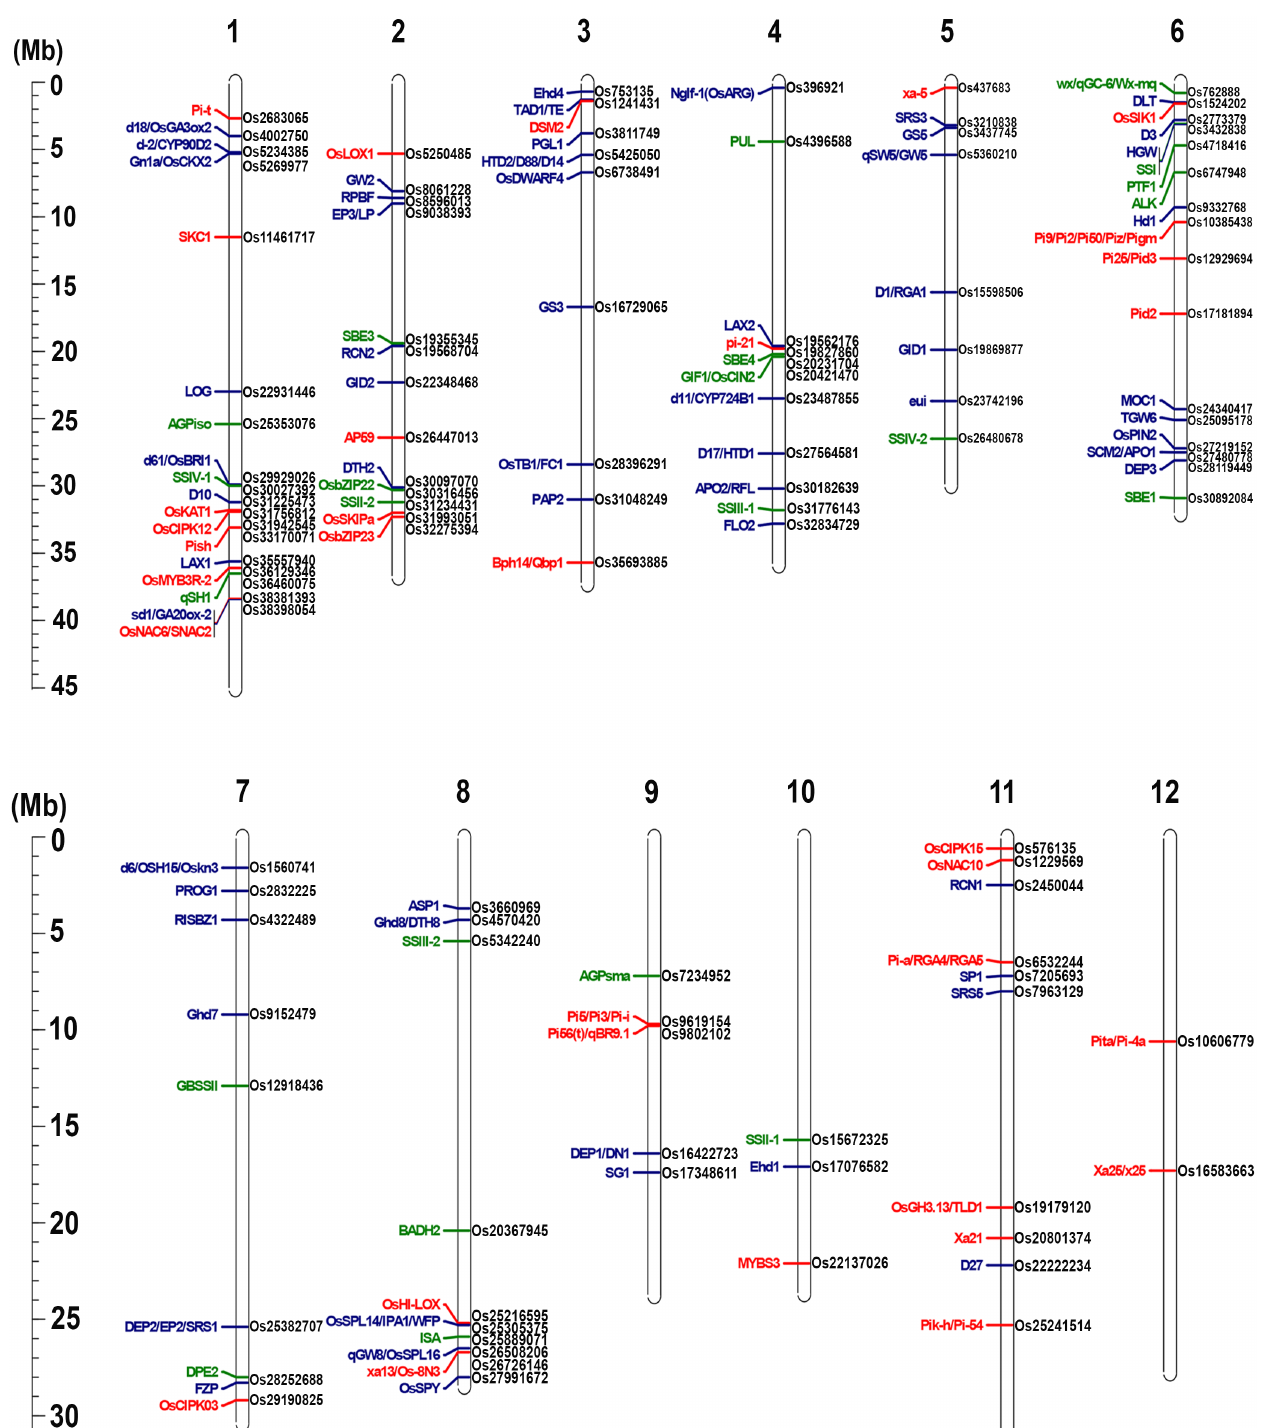
Fig 3. Identification of markers associated with rice agronomic genes between JP69 and Jiaoyuan5A. Distribution of rice agronomic genes and linked markers. Red represents disease resistance related genes; blue represents yield related genes; green represents quality related genes. Genes are labeled on the left of chromosomes; linked markers of each gene are labeled on the right. Those incorrect markers have been replaced, and all listed markers have been validated.